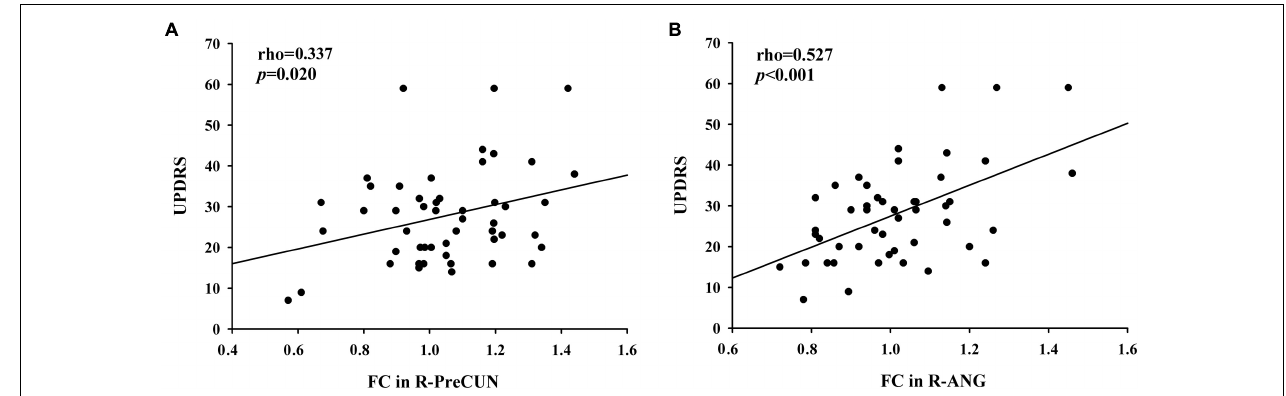
FIGURE 3 | (A) Positive correlations between enhanced functional connectivity (FC) between the PCC and the right PreCUN and UPDRS-III scores in patients with PD (rho = 0.337, p = 0.02). (B) Moreover, the enhanced FC values in the right ANG were positively associated with the Unified Parkinson’s Disease Rating Scale part III (UPDRS-III) scores (rho = 0.527, p < 0.001).